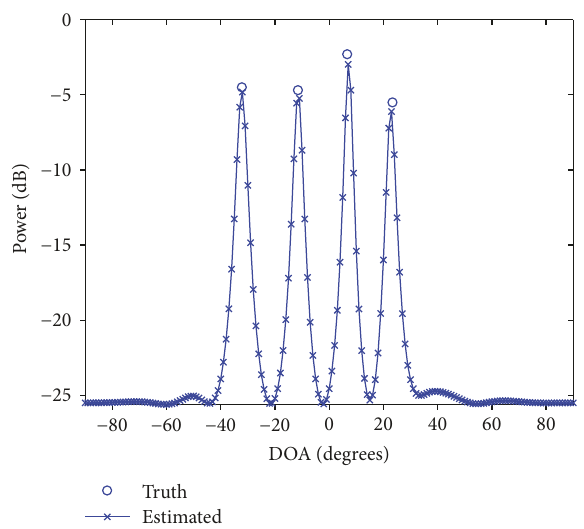
Figure 3: Spectra for the proposed algorithm with the fi xed SNR 0dB and number of snapshots 200.